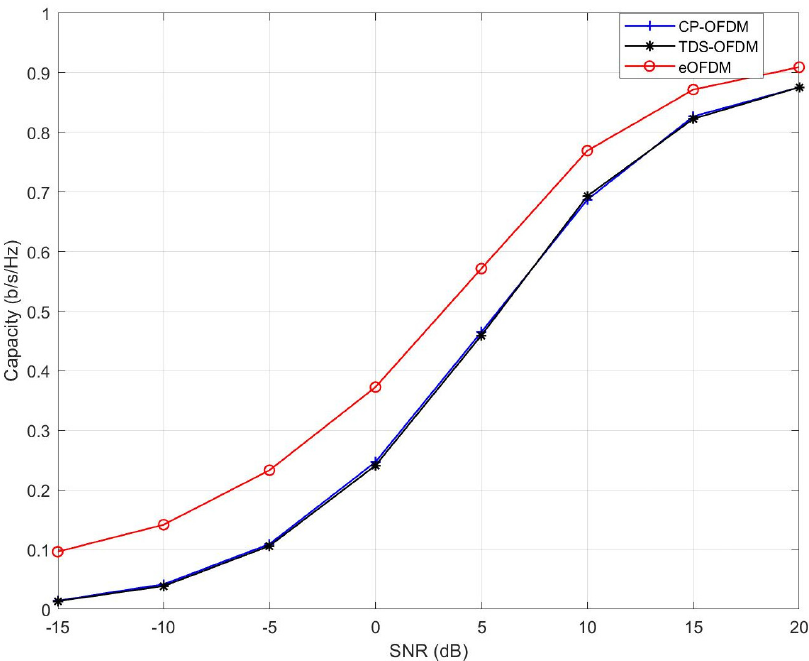
Figure 7. Capacity of CP-OFDM, TDS-OFDM and eOFDM in multipath Rayleigh fading